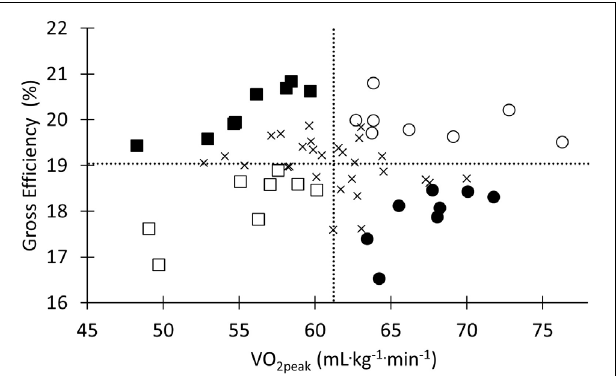
FIGURE 1 | Participant distribution of ˙ V O 2peak relative to body mass and GE at the baseline measurement. Open circles indicate participants in the HH (high ˙ V O 2peak and high efficiency) group. Filled circles indicate participants in the HL (high ˙ V O 2peak and low efficiency) group. Filled squares indicate participants in the LH (low ˙ V O 2peak and high efficiency) group. Open squares indicate participants in the LL (low ˙ V O 2peak and low efficiency) group. X indicates subjects not included in any of the sub groups ( N = 28). Dotted lines indicate the mean value for ˙ V O 2peak and gross